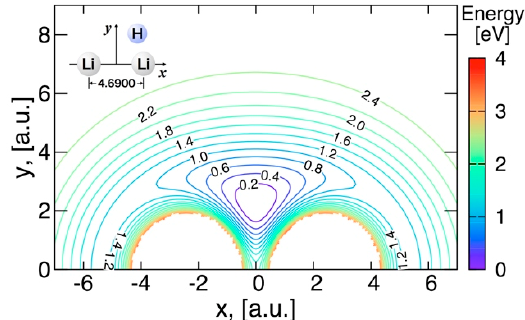
Figure 8. Energy contours when the H atom moves around a fixed Li − Li distance with r(Li − Li) = 4.690 a.u. The center of mass of Li 2 is at the origin. The energy contours are equally spaced by 0.2 eV, starting at the ground state minimum.